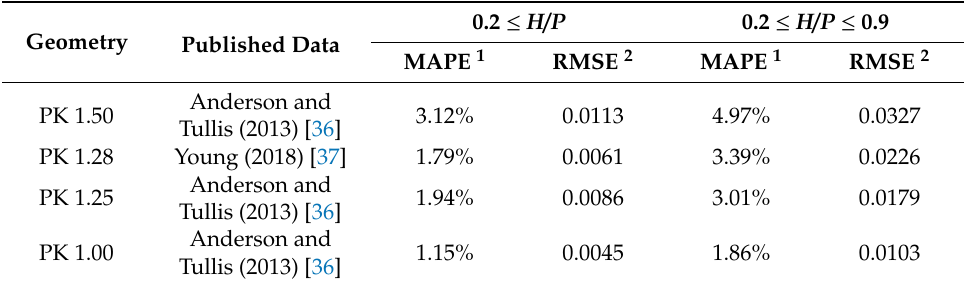
Table 2. Q comparison for corresponding H between the present study and published data for Type A PK